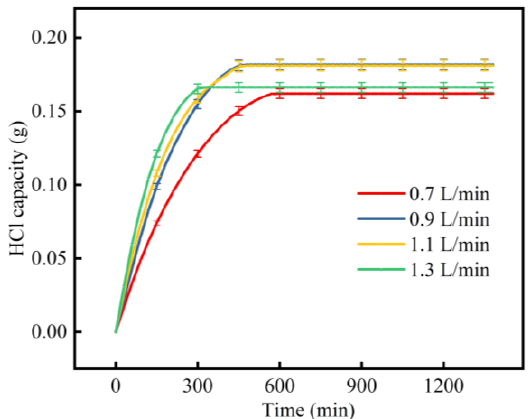
Figure 8. HCl removal capacity at different gas velocities.